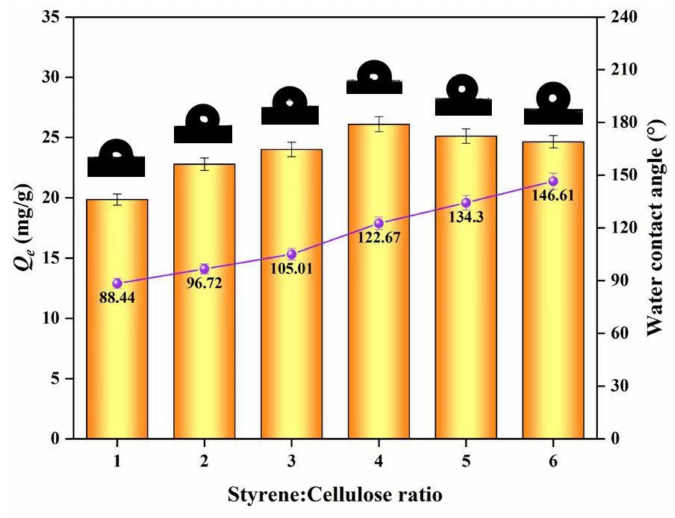
Figure 6. The relationship of adsorption amount and samples with different water contact angles. Based on the above results, we speculate that the mechanism for cellulose-St to adsorb NB is shown in Scheme 2. In the adsorption process of NB onto cellulose, the NB